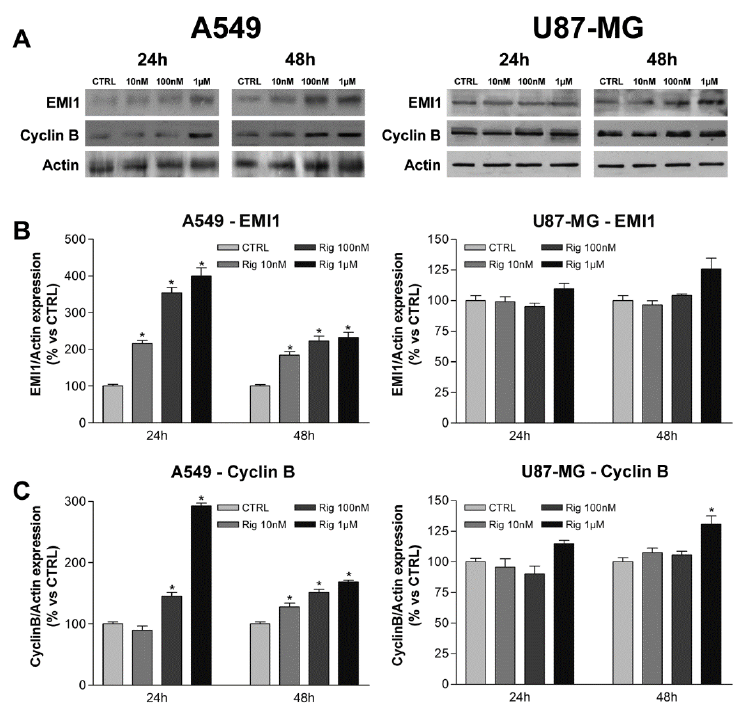
Figure 6. EMI1 and Cyclin B protein expression in A549 and U87-MG cells. ( A ) Representative images of EMI-1 and Cyclin B western blots of A549 and U87-MG cells. ( B ) EMI1 and ( C ) Cyclin B protein expression in A549 and U87-MG cells treated with increasing concentrations of RIG (10 nM, 100 nM, and 1 µM) for 24 and 48 h. Graphs represent the mean ± SD of protein expression normalized to actin and to untreated controls, set at 100%. (* p < 0.05 vs. CTRL).